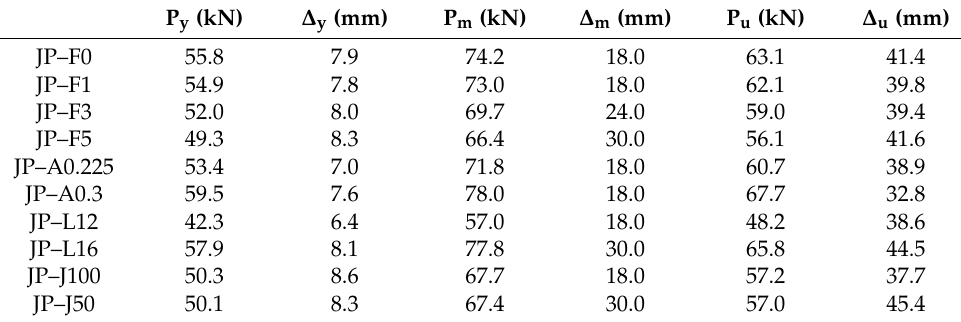
Table 6. The characteristic value of the hysteresis curve.